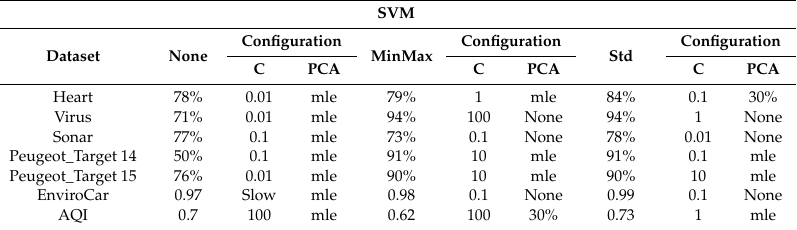
Table 17. Performance and configuration of SVM for di ff erent scaling